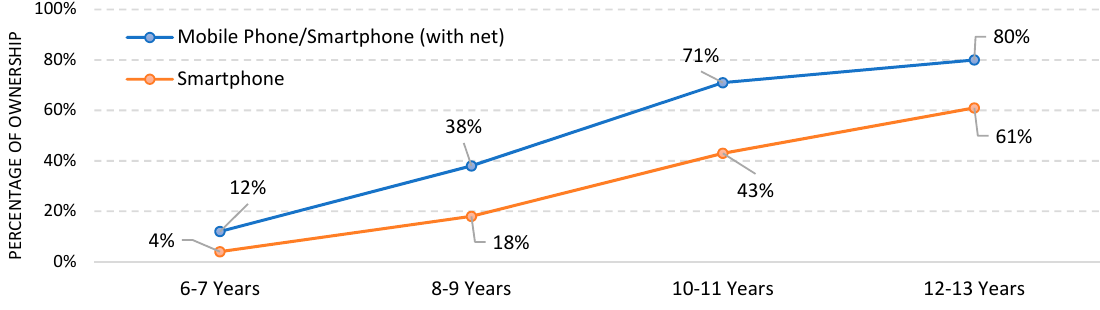
Figure 4. Smartphone ownership split among tween sub-groups.